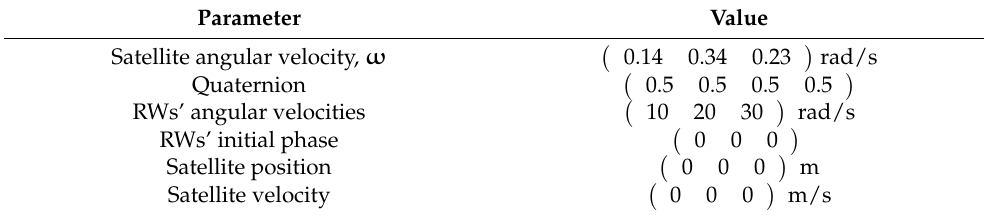
Table 2. Initial